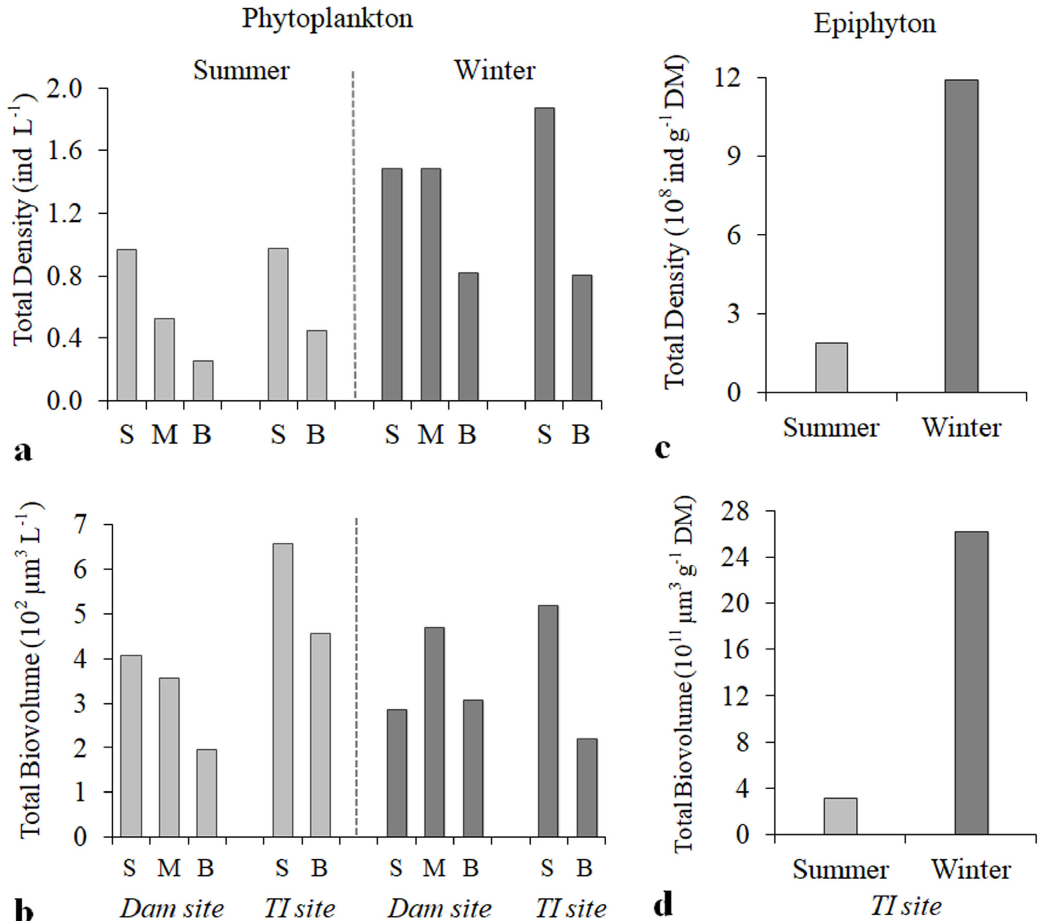
Figure 3. Phytoplankton ( a, b ) and epiphyton ( c, d ) total density and biovolume in an urban hypereutrophic reservoir during the study period (S: subsurface, M: middle, B: